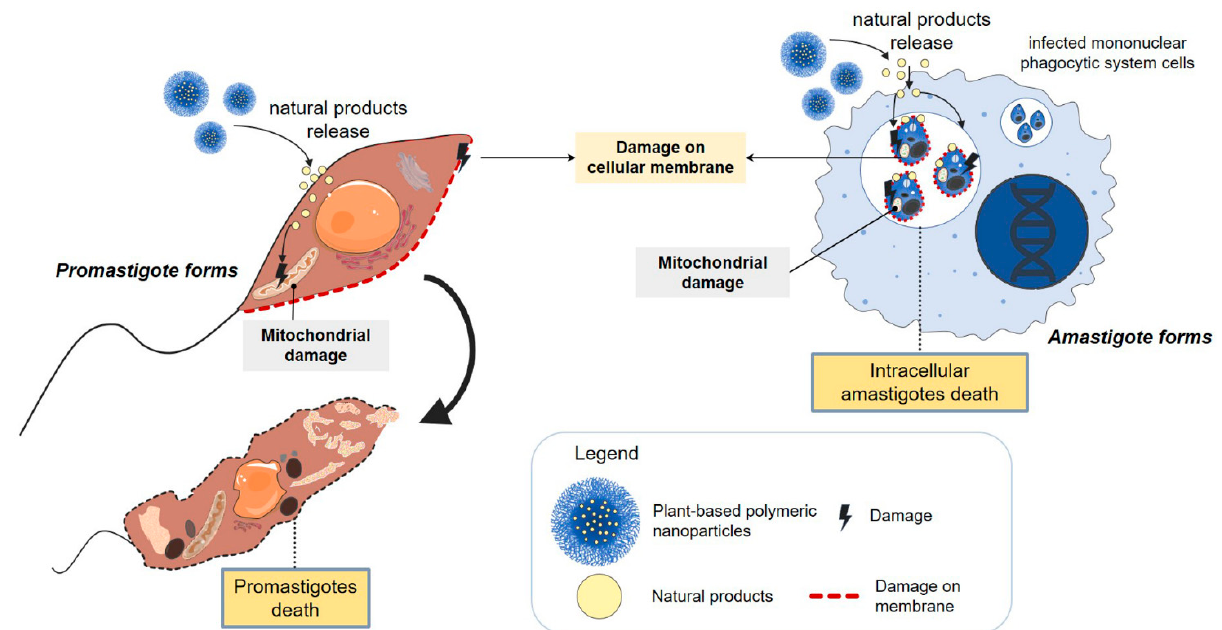
Figure 4. Schematic representation of the association of plant-based natural products with polymeric nanoparticles. Polymeric nanoparticles loaded with plant-based products allow for targeted and effi- cient delivery of anti-Leishmania agents, promoting changes in cellular structures and mitochondrial damage, leading to the death of promastigote and the intracellular amastigote